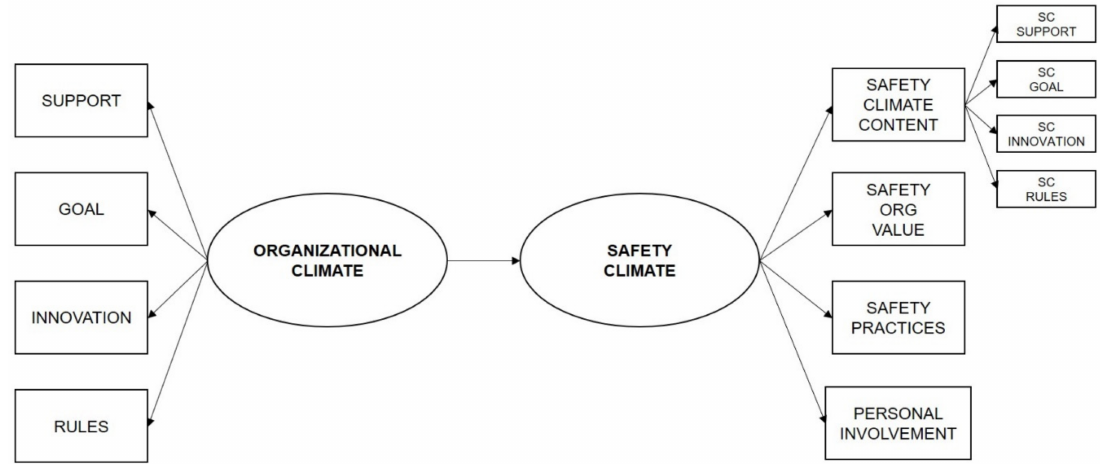
Figure A1. Theoretical Model of the Organizational and Safety Climate Inventory (OSCI.)